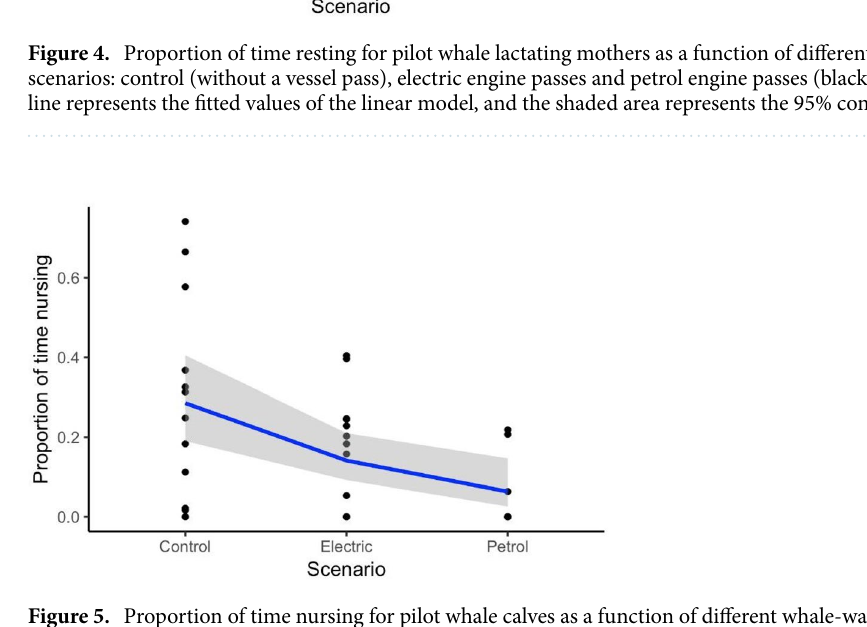
Figure 5. Proportion of time nursing for pilot whale calves as a function of different whale-watching scenarios: control (without a vessel pass), electric engine passes and petrol engine passes (black dots). The solid line represents the fitted values of the linear model, and the shaded area represents the 95% confidence